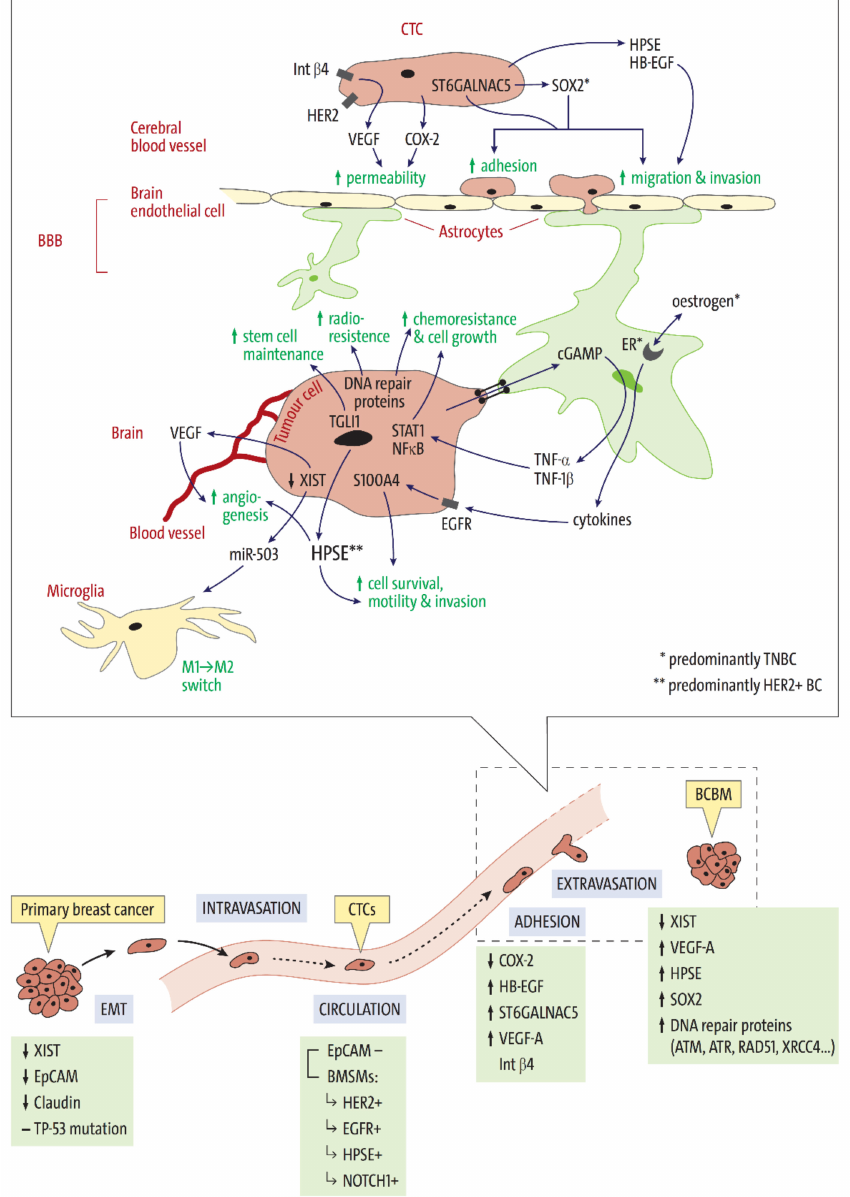
Figure 1. Lower panel: Schematic summary of the stages of breast cancer brain metastases (BCBM) development and the genetic and molecular variables relating to each metastasis step. A breast cancer cell separates from the primary tumor mass via epithelial-mesenchymal transition (EMT)